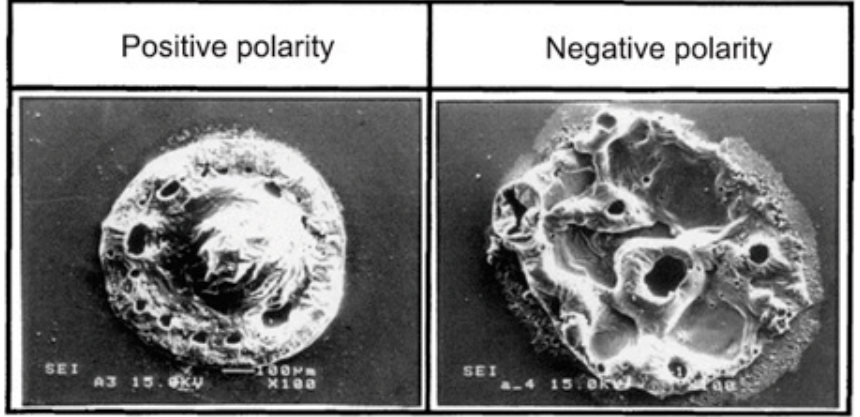
Figure 6. The outcome of polarity variation on the machined surface [52].